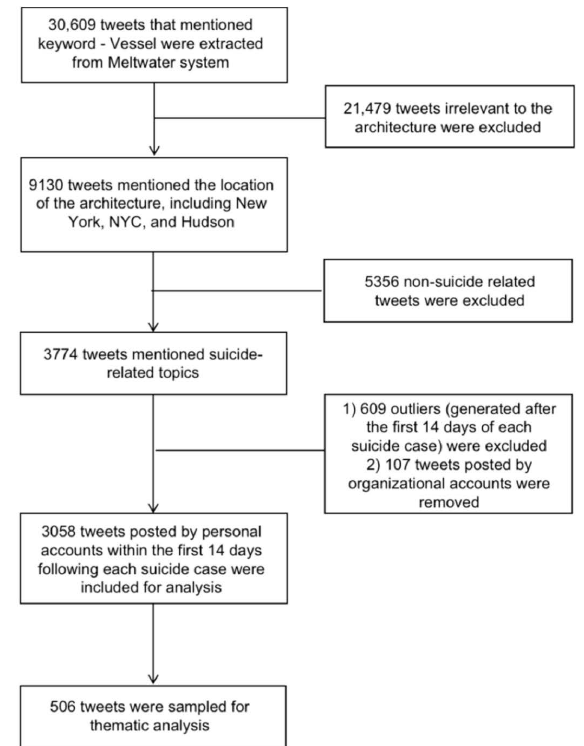
Figure 3. Dataset summaries and criteria for inclusion in engagement and thematic analysis, from February 2020 to August